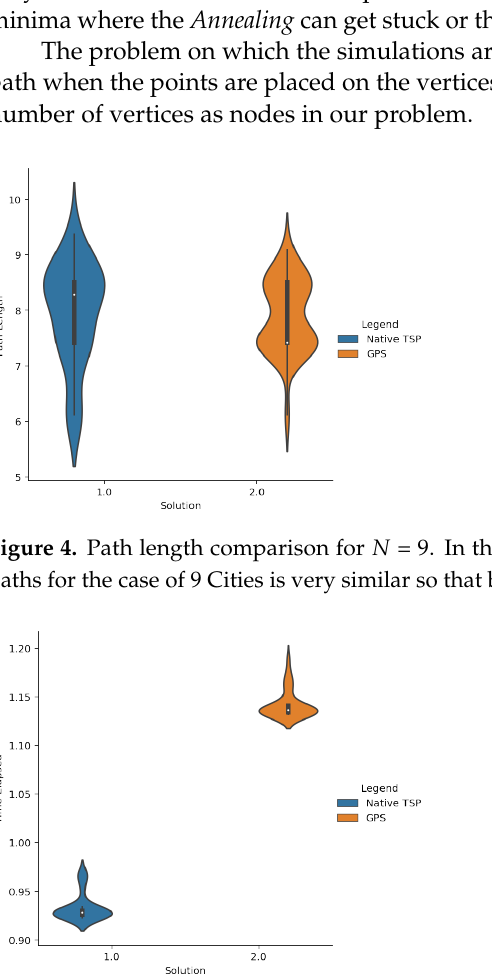
Figure 5. Time comparison for N = 9. This graph shows the time taken to carry out the executions in the case of 9 cities. Although it seems that there is a lot of difference, it only represents 10% of the total time, which, as we have seen in other experiences, is not